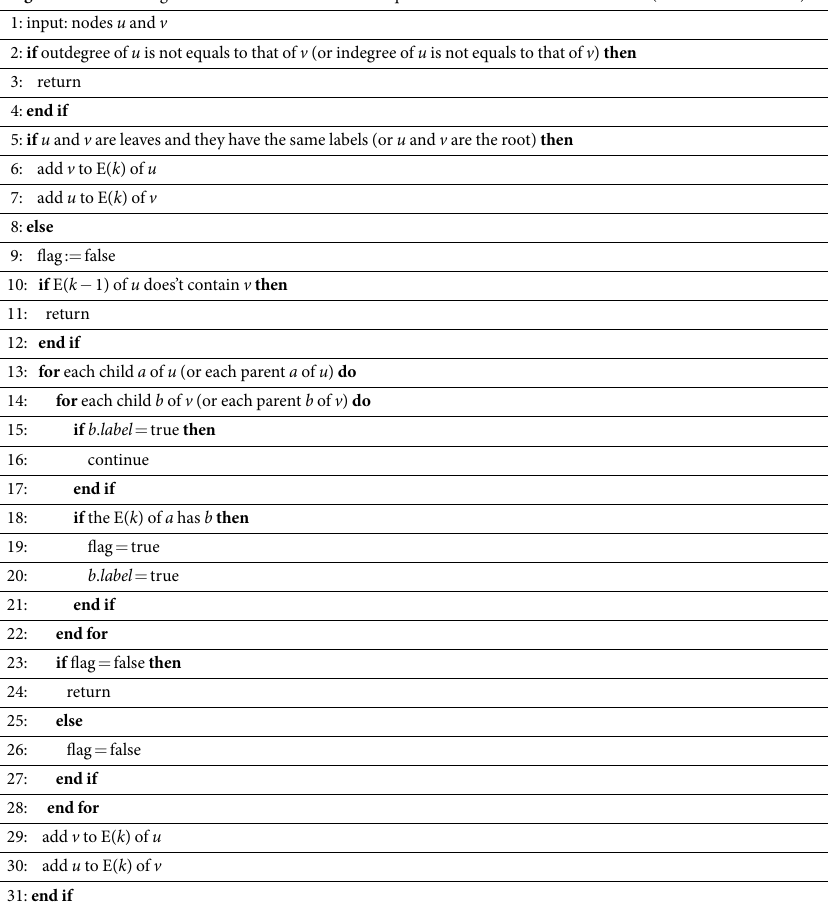
Algorithm 1 : Deciding whether u and v are k th-order equivalent or not for an odd number k (or an even number k